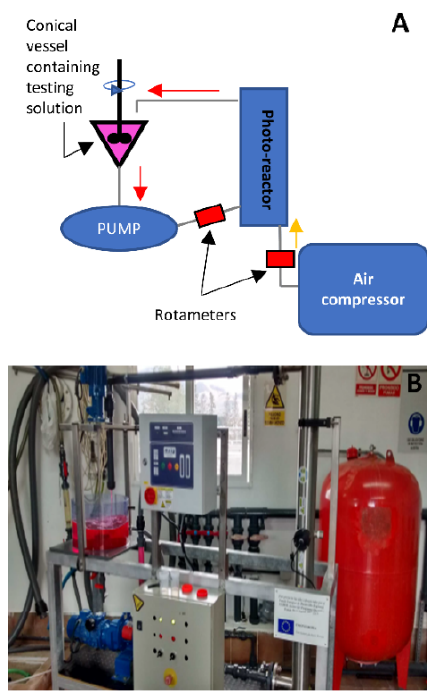
Figure 2. Employed pilot plant: ( A ) scheme and ( B ) picture.